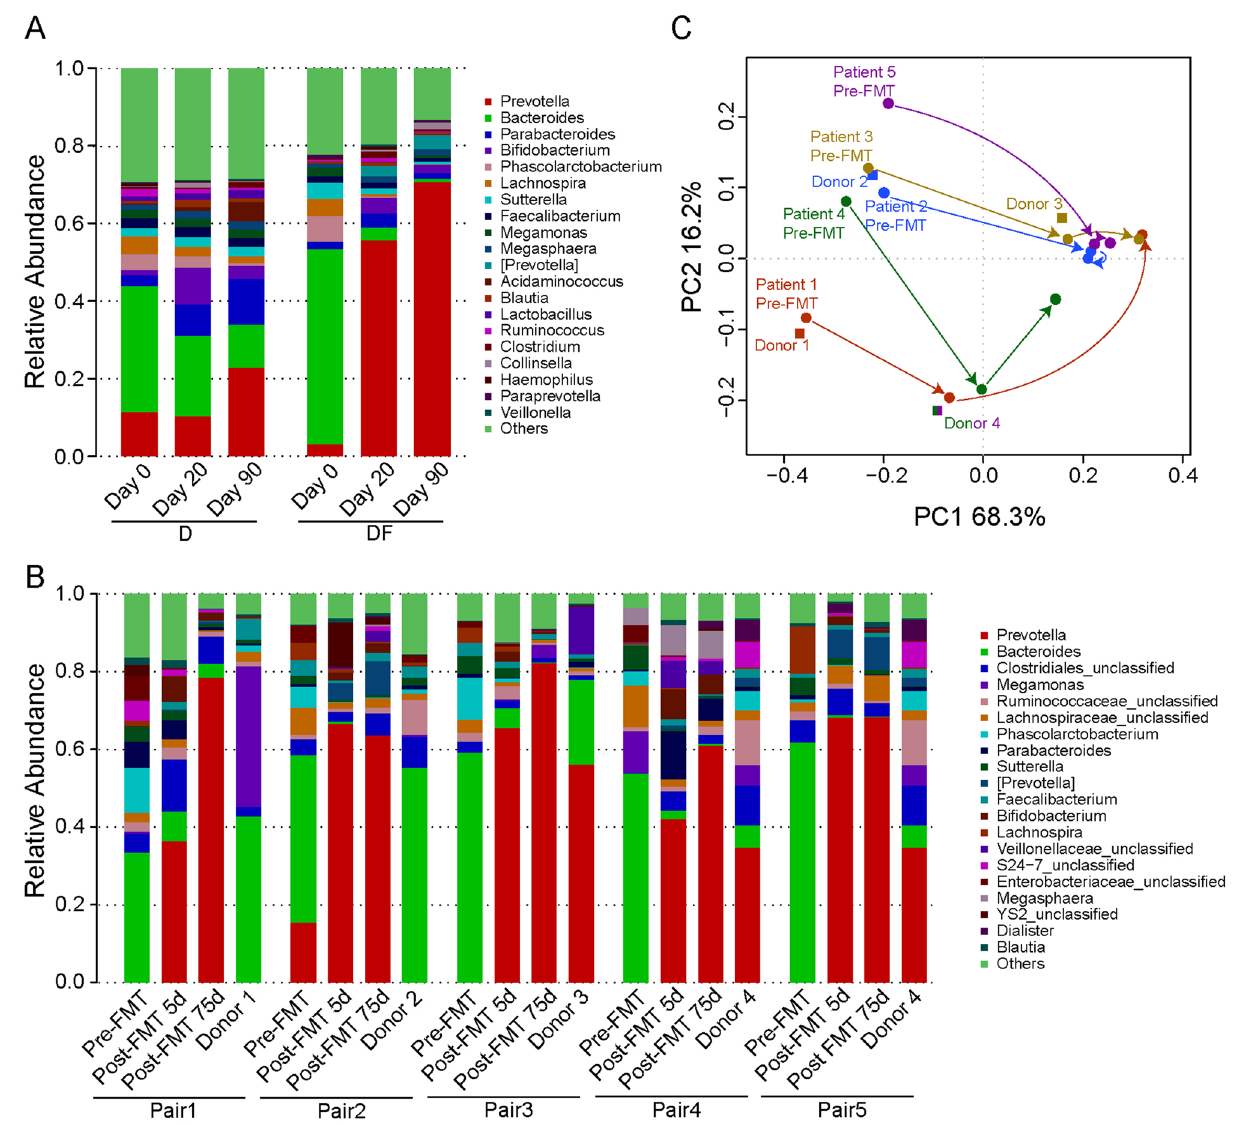
Figure 4. Changes of the composition of fecal microbiota. ( A ) Bacterial composition at the genus level in each group. ( B ) Bacterial composition at the genus level of each person receiving the FMT and the paired donor. ( C ) PCoA of weighted UniFrac distances before and after